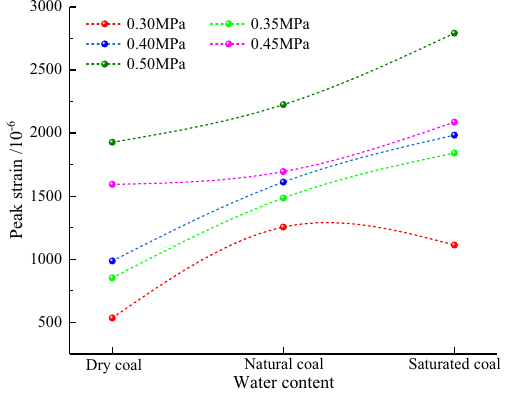
Figure 8. Peak strain versus water content.